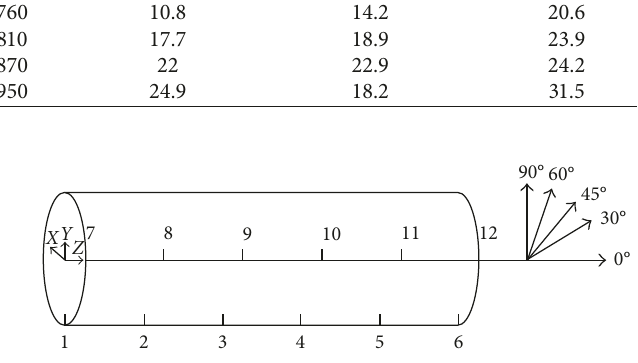
Figure 2: The schematic diagram at different incident